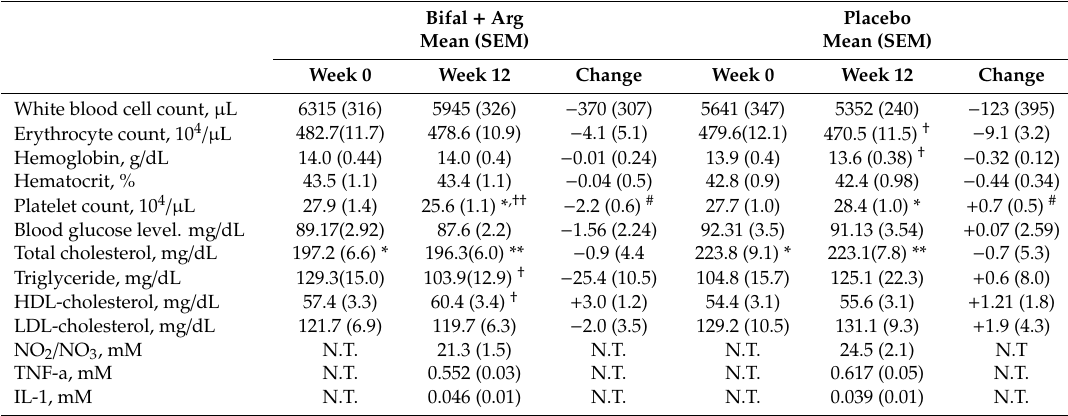
Table 2. E ff ects of yogurt containing B. animalis subsp. lactis and arginine on blood